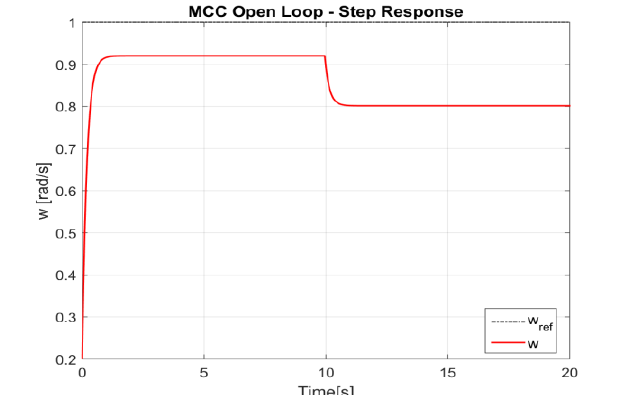
Figure 3. Step response of DC motor